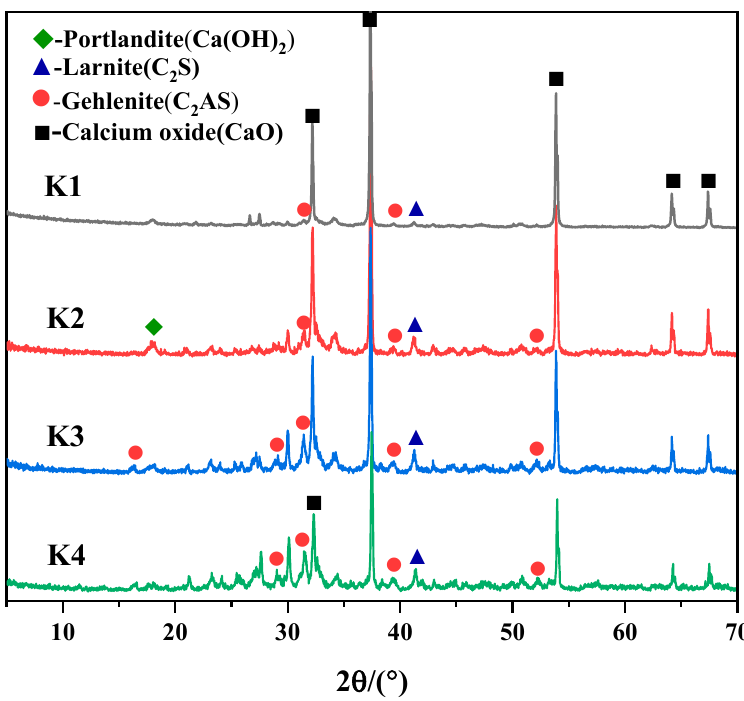
Figure 2. XRD results of the calcined products for 3 h at 1000 °C at different ratios. Table 2. Mass percentage of the air-hardening component and hydraulic component for K1, K2, K3, K4, NHL2, and NHL5.